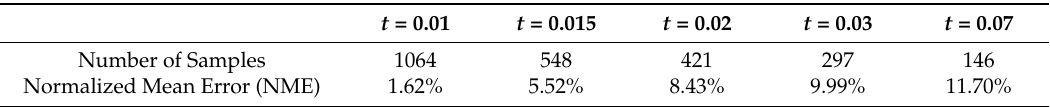
Table 1. Results with different threshold values for DO data sampling.